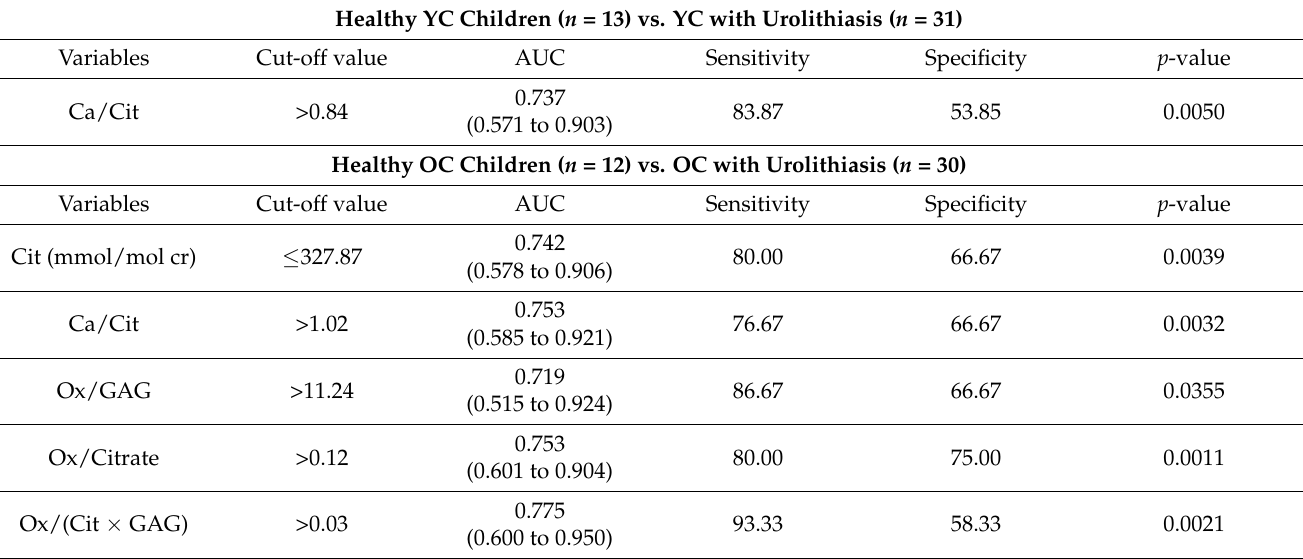
Table 3. Summary of ROC analysis for statistically significant